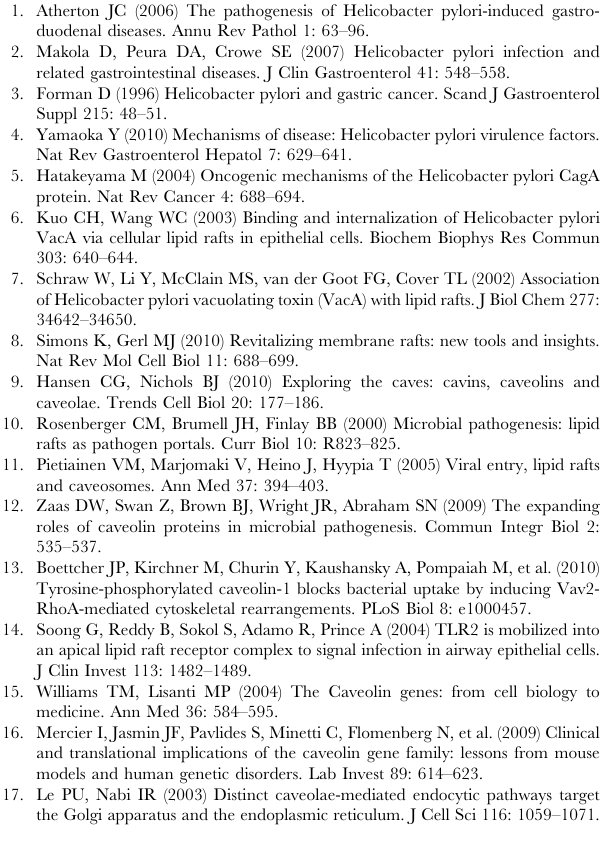
Table S1 Oligonucleotides. DNA-sequences of 5 9 -(forward) and 3 9 -(reverse) primers for detection of human, mouse and H. pylori genes by RT-qPCR are listed. Oligonucleotide sequences from the human CAV1 gene promoter containing SREs were used for performance of EMSA and ChIP assays. Table S2 DLC1 peptides identified by MALDI-MS. The amino acid sequence and the localization of peptides precipitated in CoIP experiments using Cav1 as a bait are presented. Peptides overlapped with both variant 1 and variant 4 of the human DLC1 protein. * Mascot total ion score by GPS Explorer 2 software; # Location of peptides identified by MALDI-MS in the coding sequence (CDS) of human DLC1 protein